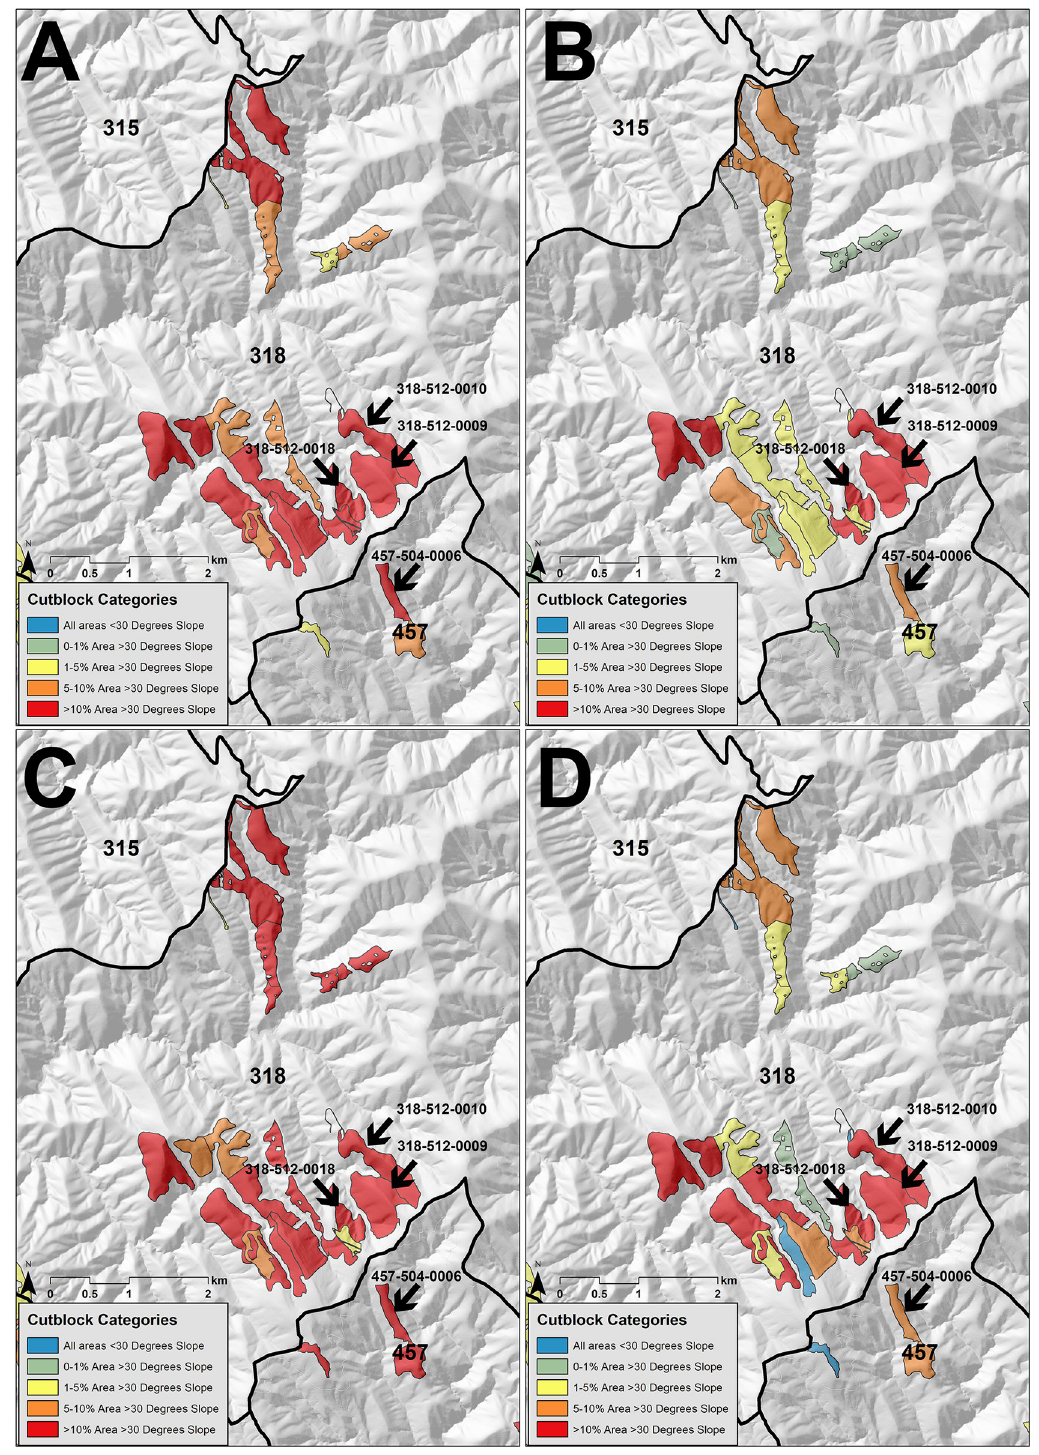
Fig 6. Percent of cut block area > 30˚ in slope across Block 318 calculated using the LiDAR 1m DEM (A), the 5 m average slope calculated using the LiDAR DEM (LiDAR F5m) (B), calculated using the VicMap Elevation DTM (C) and calculated using the SRTM DEM